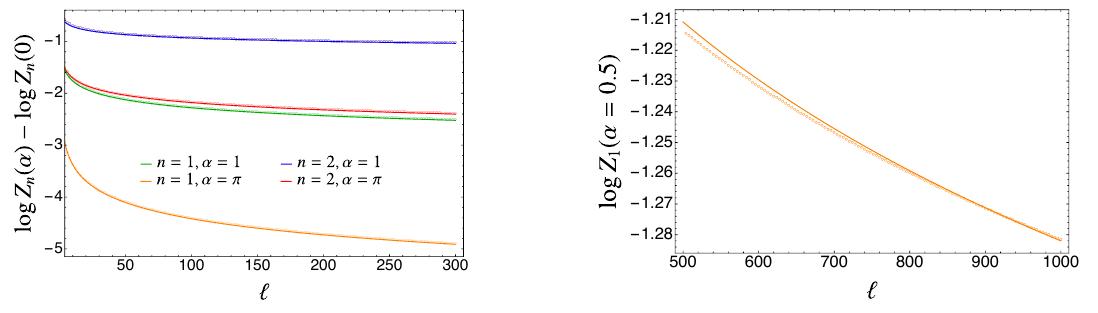
Figure 9 . Charged moments for the free massive boson close to the critical regime. We benchmark the analytical prediction (5.11) (solid lines) with the numerical data (symbols) for di(cid:11)erent values of n and (cid:11) at (cid:12)xed m = 10 (cid:0) 10 : the analytical formula matches well the data for large values of (cid:11) (left), but for smaller (cid:11) (right) much larger values of ‘ are necessary to observe a fair match, as explained in the